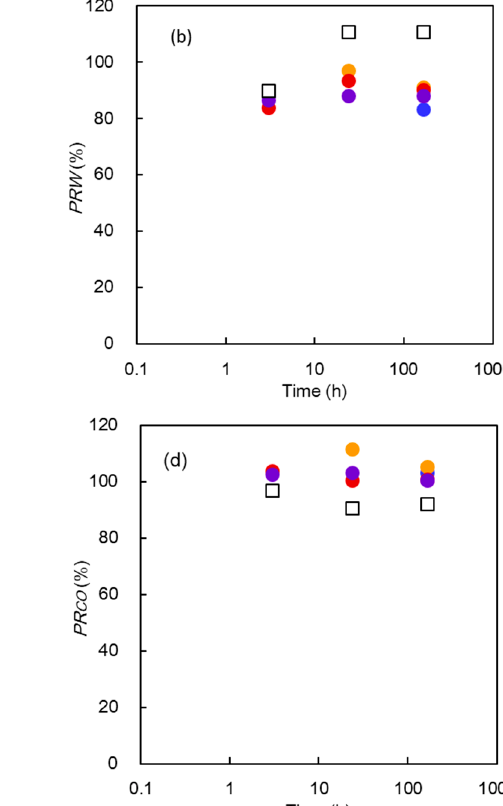
( b ) Figure 7. Normalized chlorine intensities obtained using XRF measurements before and after immersion in solutions of different alkali concentrations ( a ) CMX ( b ) AMX. 3.2.3. Characterization of Membrane Properties Figure 8 shows the normalized properties of CMX as a function of NaOH concentration and immersion time periods. For comparison, the data corresponding to AMX immersed in 1 M NaOH [18] were also included in these figures. In the case of AMX, a decrease in the normalized Young’s modulus, an increase in the